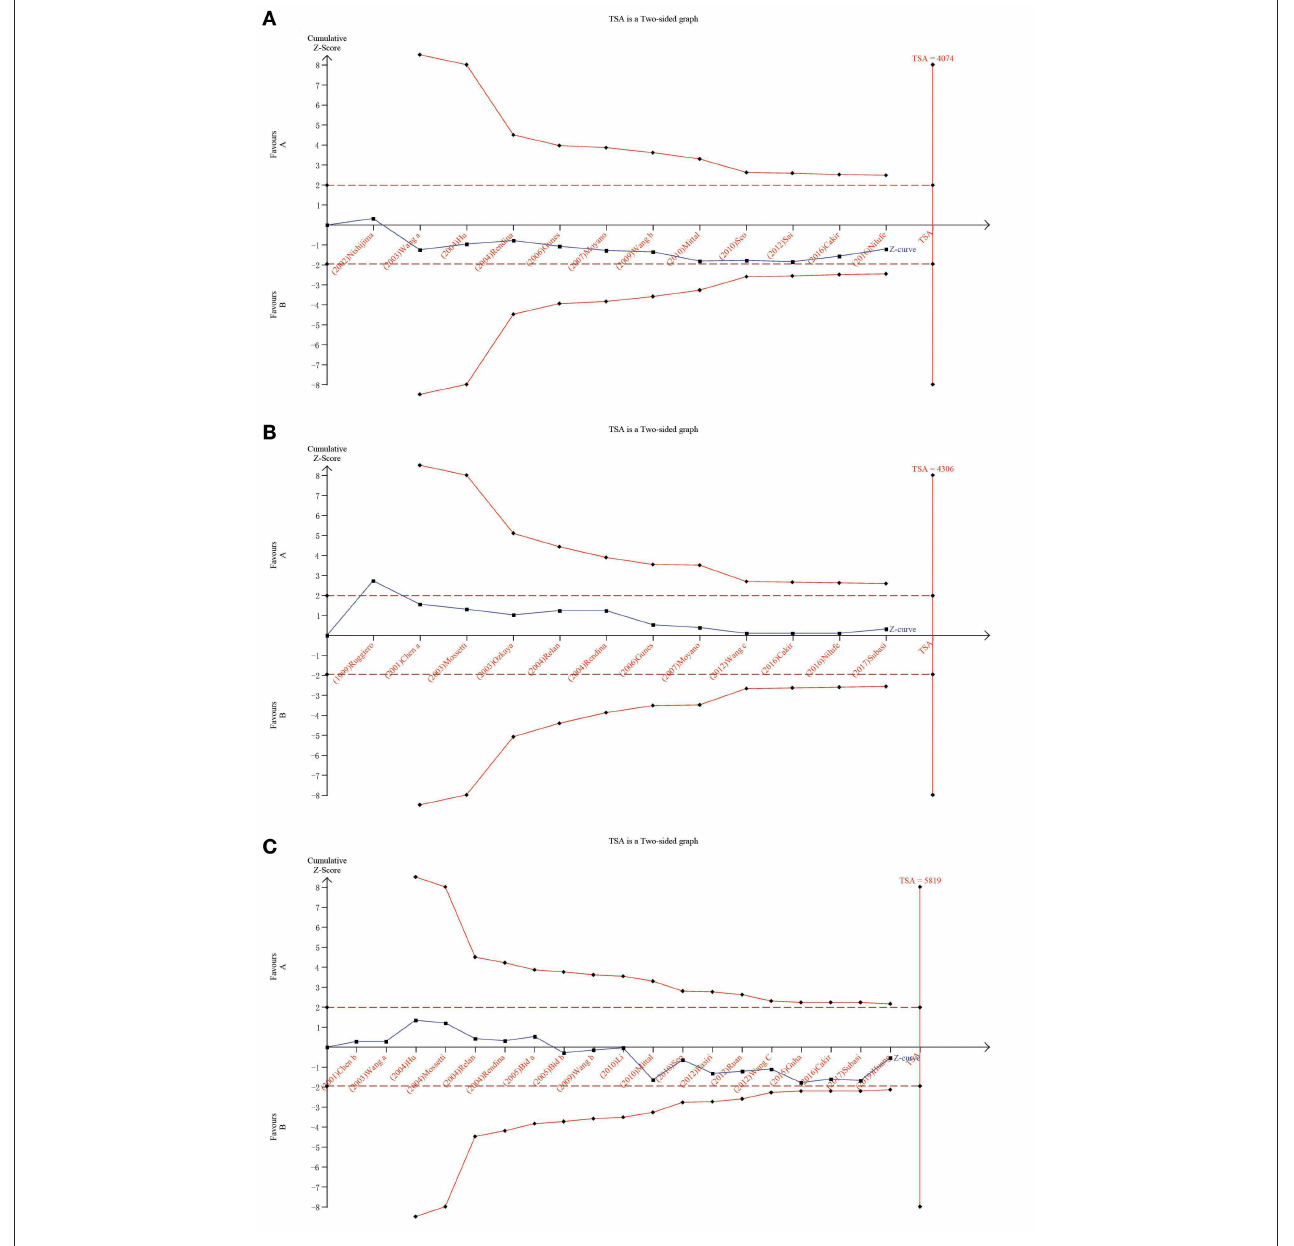
FIGURE 6 | Results of TSA with BsmI, ApaI , and FokI variants. The required information size was calculated based on a two-sided α = 5%, β = 15% (power 80%), and a relative risk reduction of 20%. (A) for ApaI ; (B) for BsmI ; and (C) for FokI